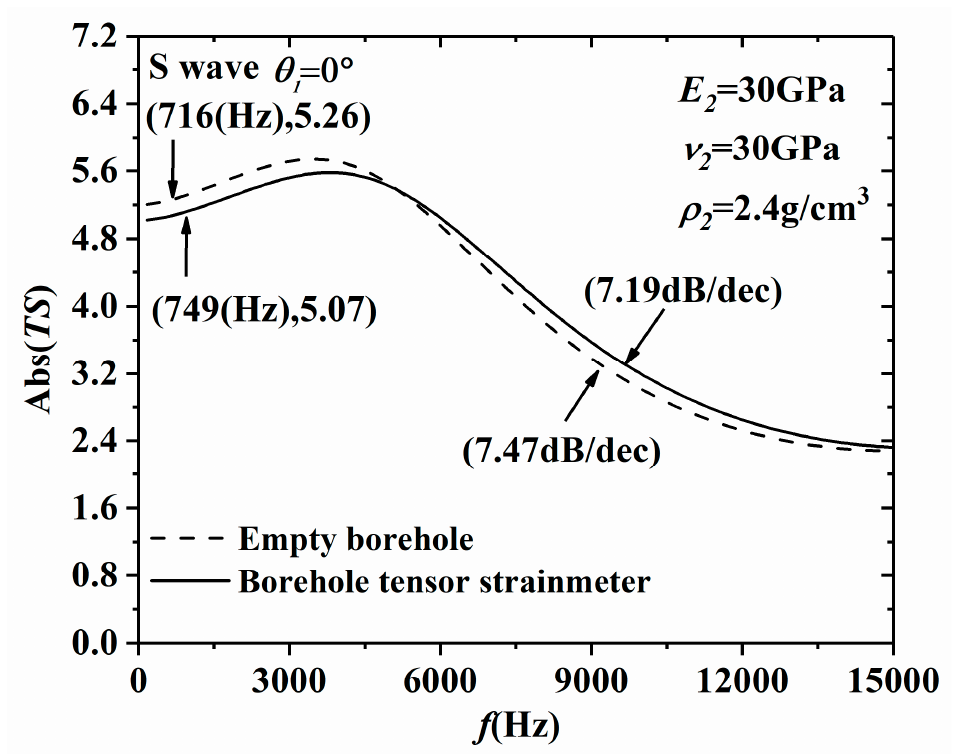
Figure 6. Theoretical amplitude spectrum of gauge combination TS for the incident S wave. 204 Table 5. Characteristic values for incident S wave amplitude spectrum of FS and TS at different θ 1. 205 θ 1 (°)